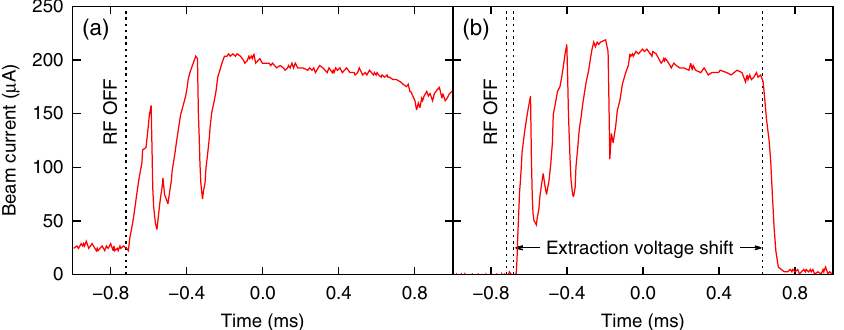
FIG. 5. The effect of the GTS-LHC extraction voltage modulation on the measured 208 Pb 29 þ beam current during the afterglow. In case (a) the modulation is not applied and consequently the steady state beam current at the end of the klystron rf pulse is observed ( t < − 0 . 72 ms), and the afterglow current continues until the end of the measured time window. In case (b) the modulation is used and these parts are discarded before the beam reaches the Faraday cup.